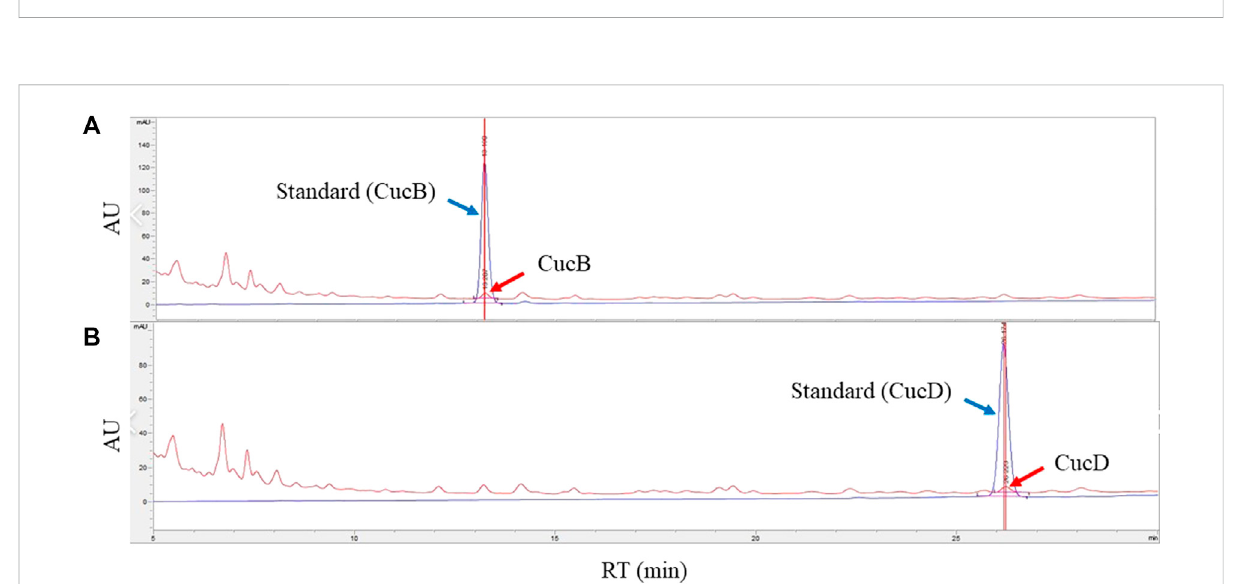
FIGURE 2 Effects of Trichosanthes kirilowii Maximowicz (TK) and its sub-component cucurbitacins B (CucB) and D (CucD) on cold and mechanical allodynia induced by multiple paclitaxel injections in mice. The experimental schedule (A) and the effects of TK, CucB, and CucD against paclitaxel- induced cold (B) and mechanical (C) allodynia in mice. Behavioraltests to measure allodynia were performed before and 1 h after thei.p. injection of PBS, 20% DMSO, 500 mg/kg of TK, .025 mg/kg of CucB, or .025 mg/kg of CucD in paclitaxel-injected mice. PBS and 20% DMSO were used as the control as they are solvents of TK and cucurbitacins, respectively. TK, Trichosanthes kirilowii Maximowicz; CucB, cucurbitacin B; CucD, cucurbitacinD;DMSO,dimethylsulfoxide;P,paclitaxel. N =6ineachgroup.* p < .05,** p < .01,and**** p < .0001 vs. controlwithtwo-wayANOVA, followed by Tukey ’ s post-test for multiple